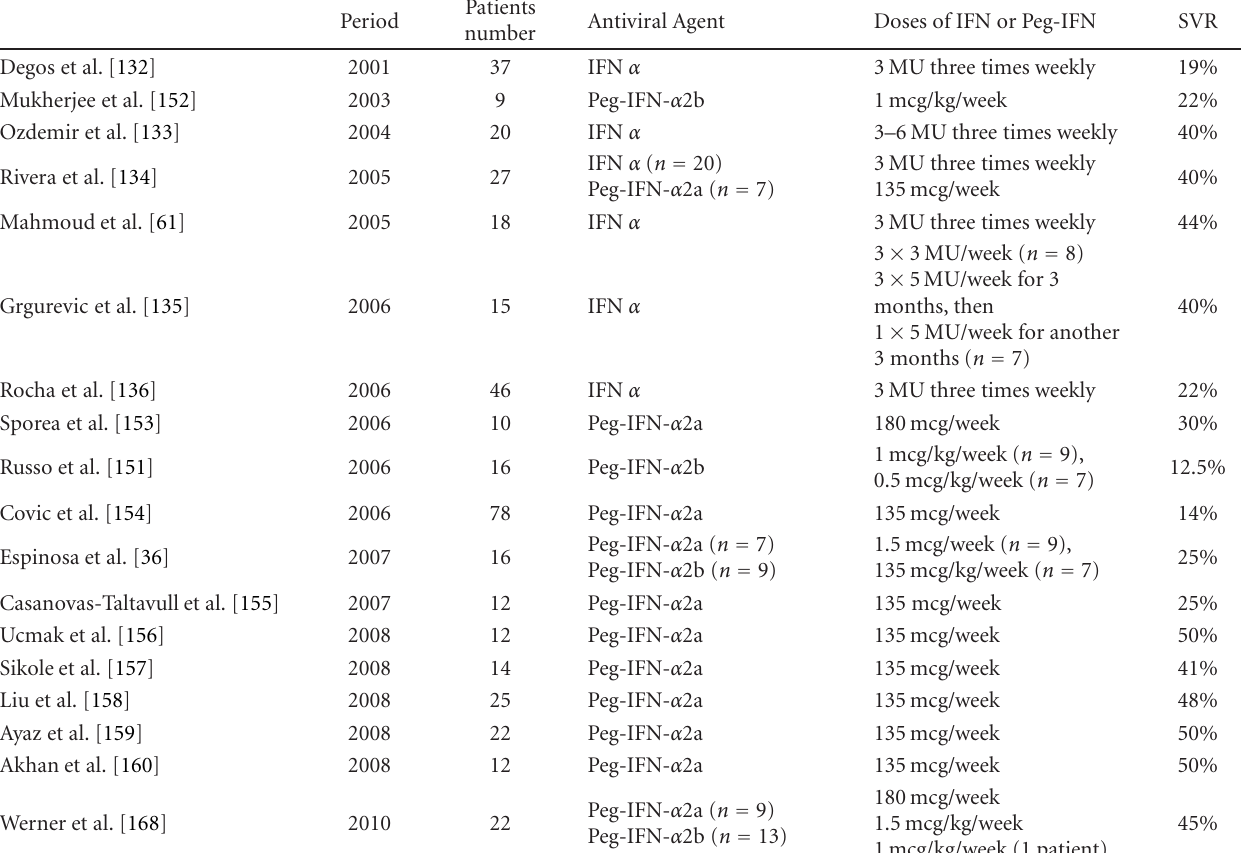
Table 4: Clinical trials of monotherapy with conventional IFN or pegylated IFN in hemodialysis patients with chronic hepatitis